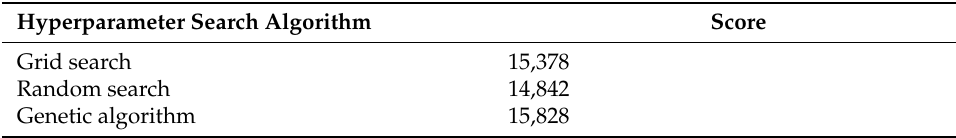
Table 2. Results of the hyperparameter search algorithms.